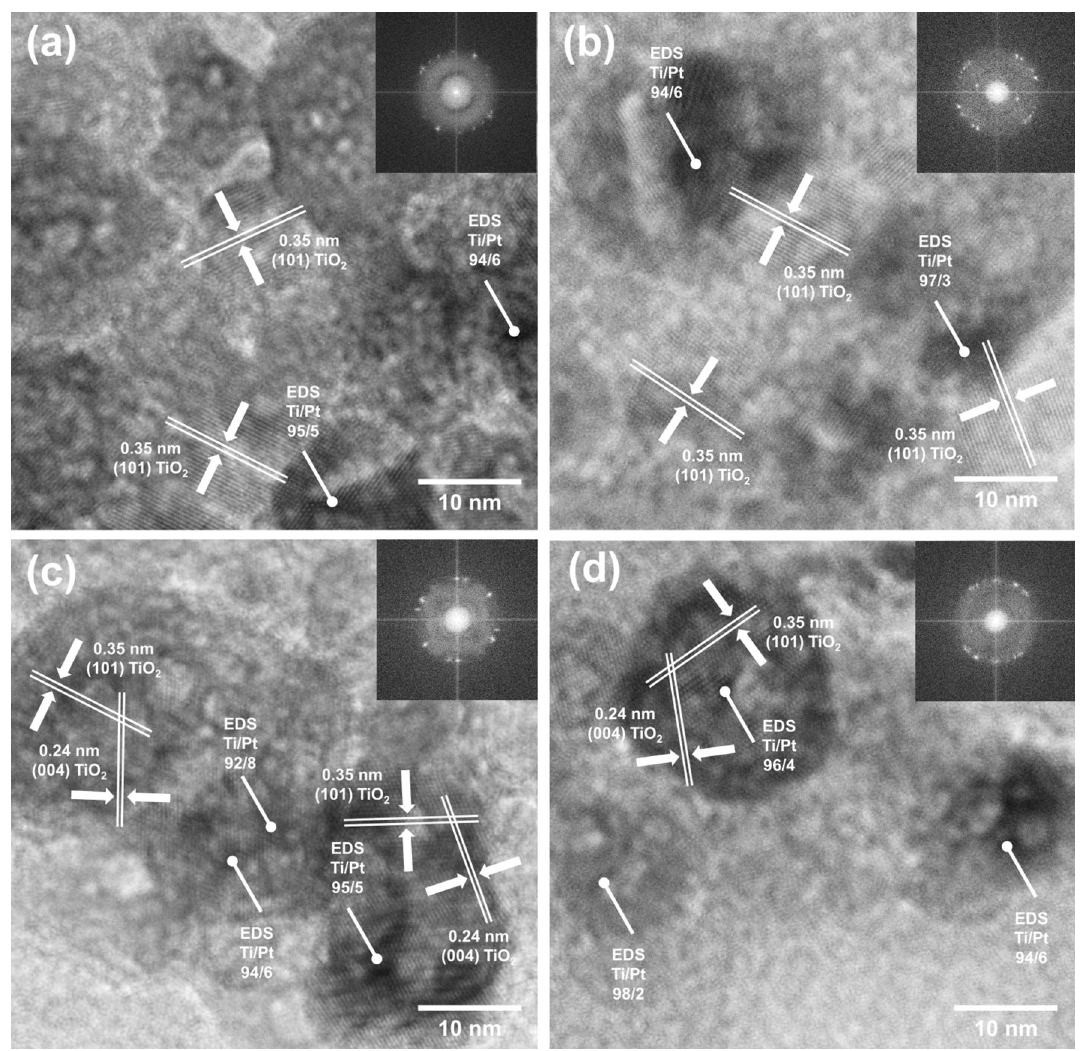
Figure 3. The HR-TEM and FFT images for selected samples: ( a ) 1 W 365 nm, ( b ) 10 W 365 nm, ( c ) 1 W 395 nm, and ( d ) 10 W 395 nm.